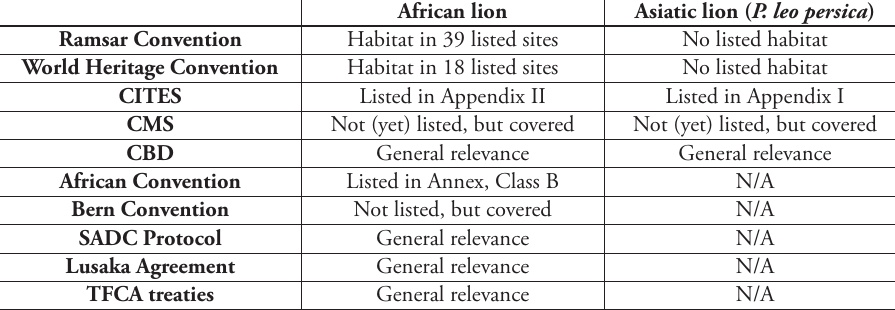
Table 1. Treaties of relevance to lion conservation. The relevance of each treaty or category of treaties is indicated for African lion subpopulations and Asiatic lion, respectively. N/A = not applicable. African lion Asiatic lion ( P. leo persica ) Ramsar Convention Habitat in 39 listed sites No listed habitat World Heritage Convention Habitat in 18 listed sites No listed habitat CITES Listed in Appendix II Listed in Appendix I Not (yet) listed, but covered Not (yet) listed, but covered General relevance General relevance African Convention Listed in Annex, Class B N/A General relevance N/A General relevance N/A TFCA treaties General relevance